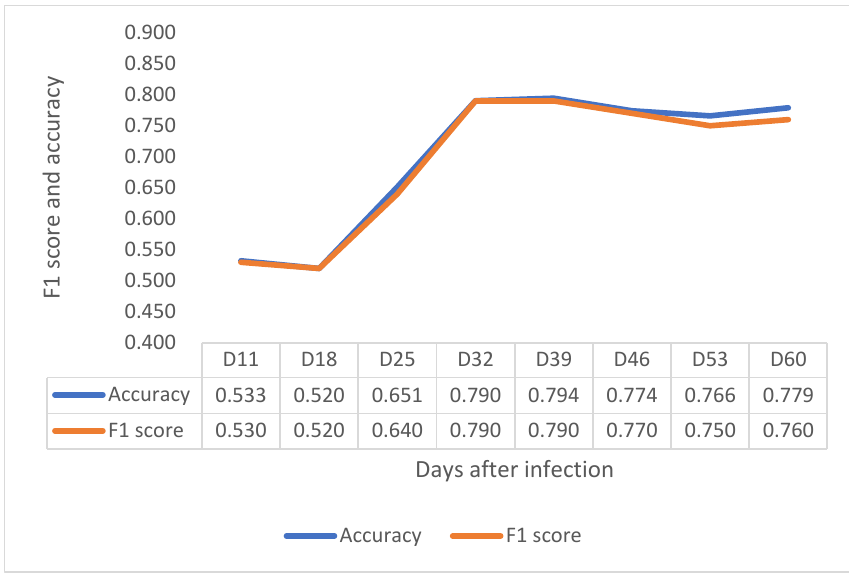
Figure 5. Depiction of F1 score and accuracy of the VNIR sensor from 11 to 60 DAI.